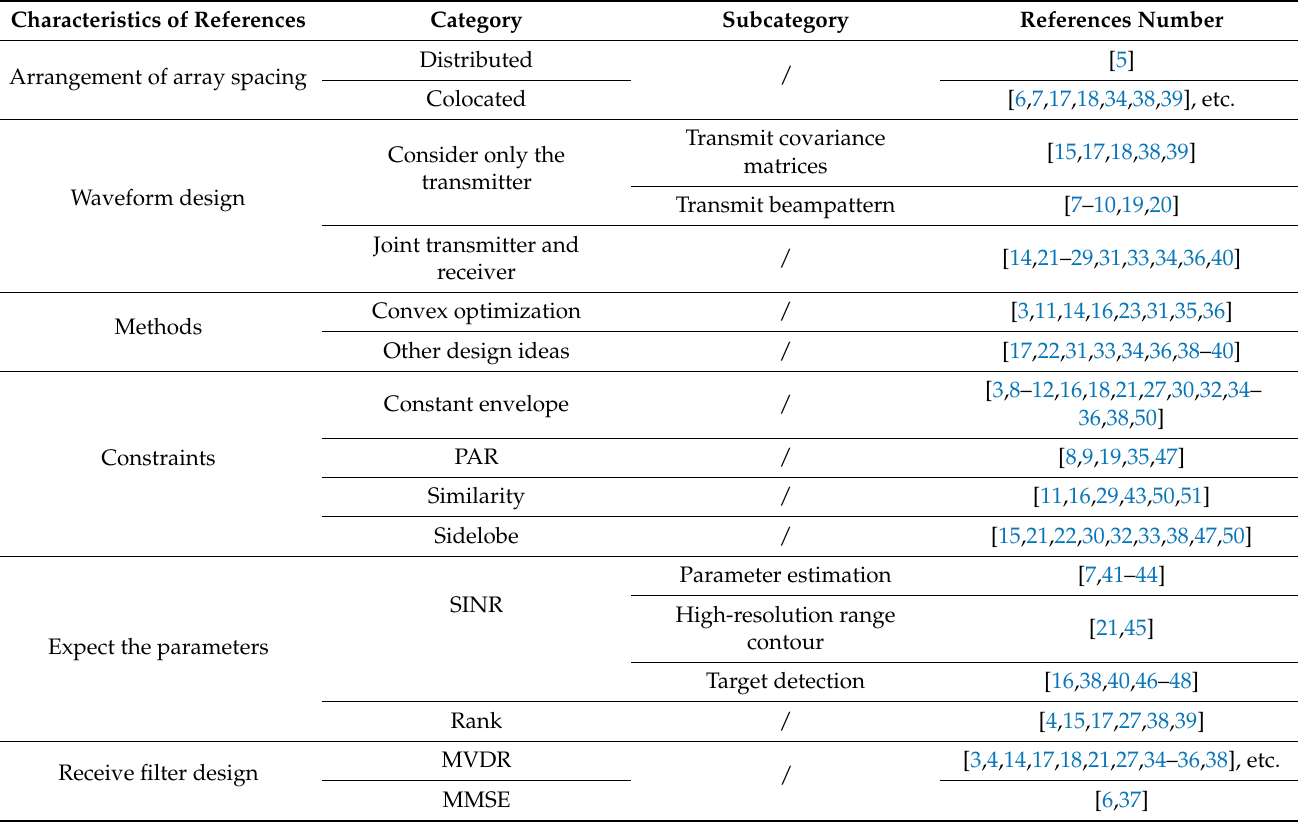
Table A1. MIMO radar references are classified according to their respective characteristics. Note that the categories in this table do not represent